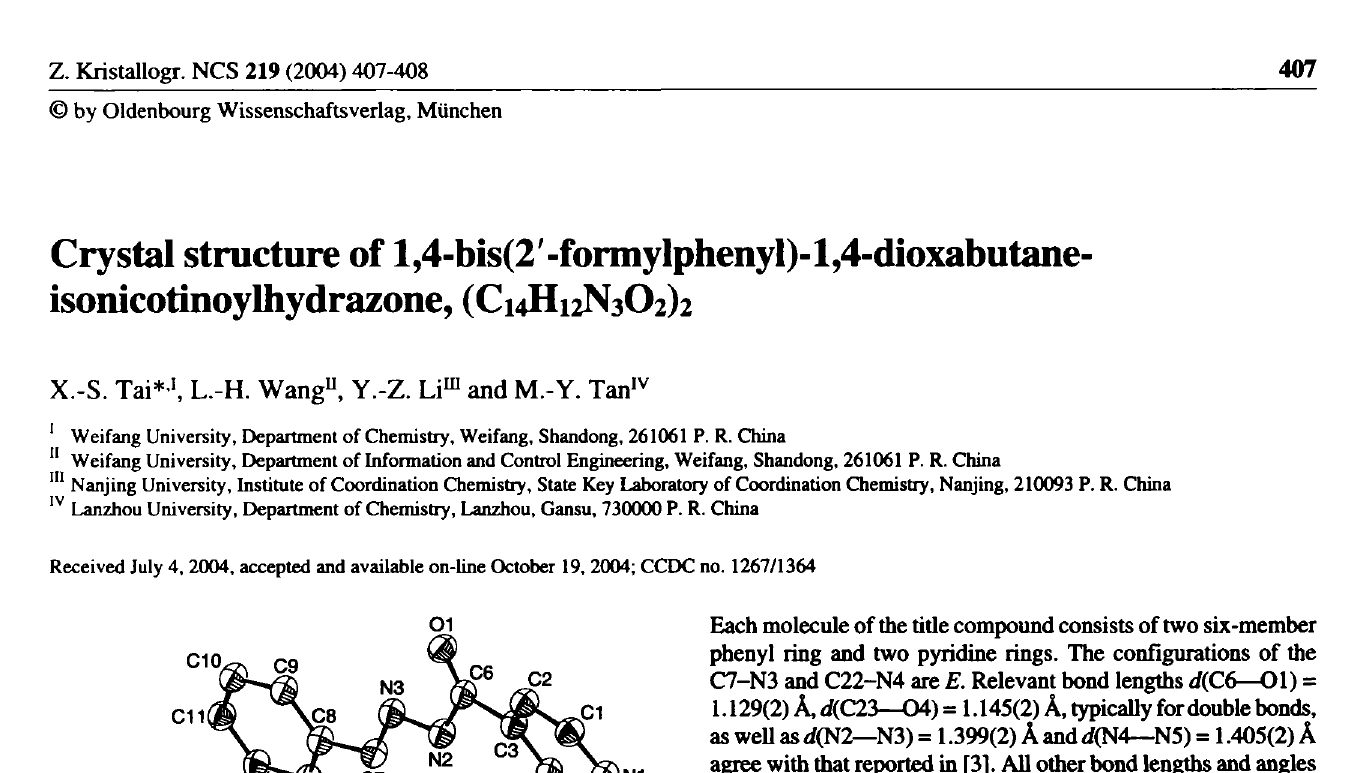
Table 1. Data collection and handling.